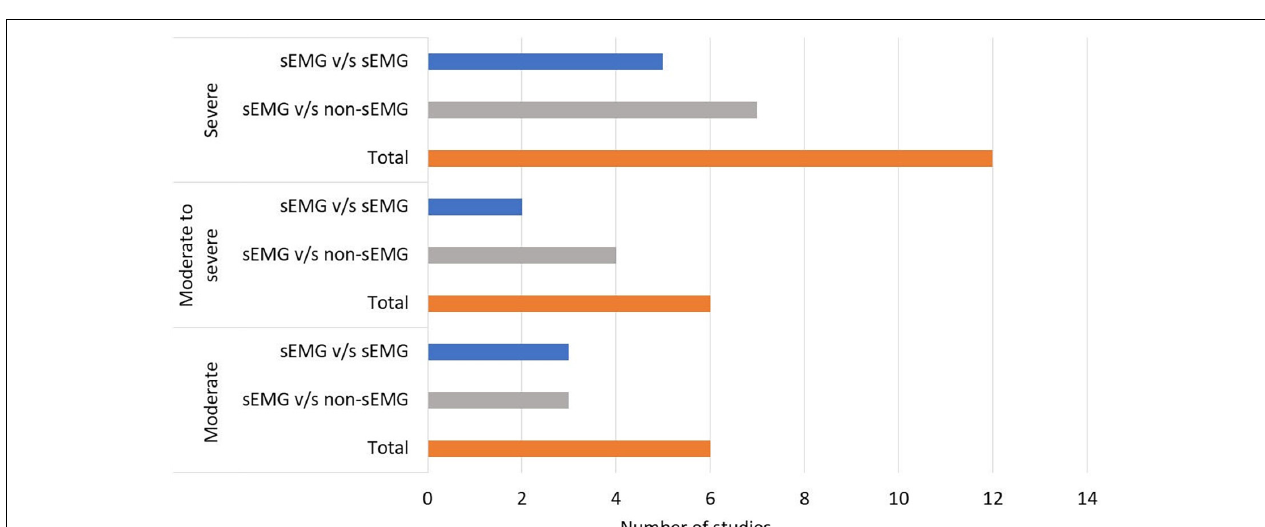
FIGURE 2 | Number of studies performed in patients with chronic and subacute stroke. s-EMG v/s sEMG, studies comparing different surface electromyography driven interventions; s-EMG v/s non-sEMG, studies comparing surface electromyography driven interventions with non-surface electromyography driven groups.